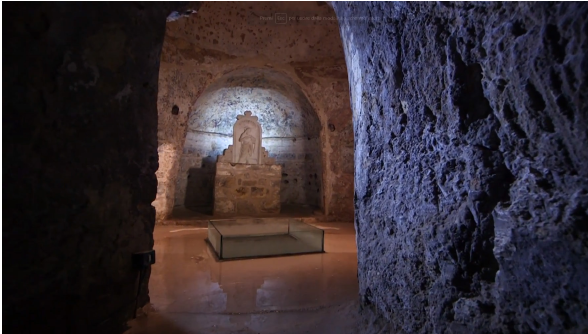
Figure 3. The entrance of the “Sybil hypogeum”.